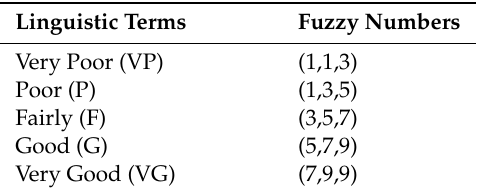
Table 5. Linguistic variables for alternative